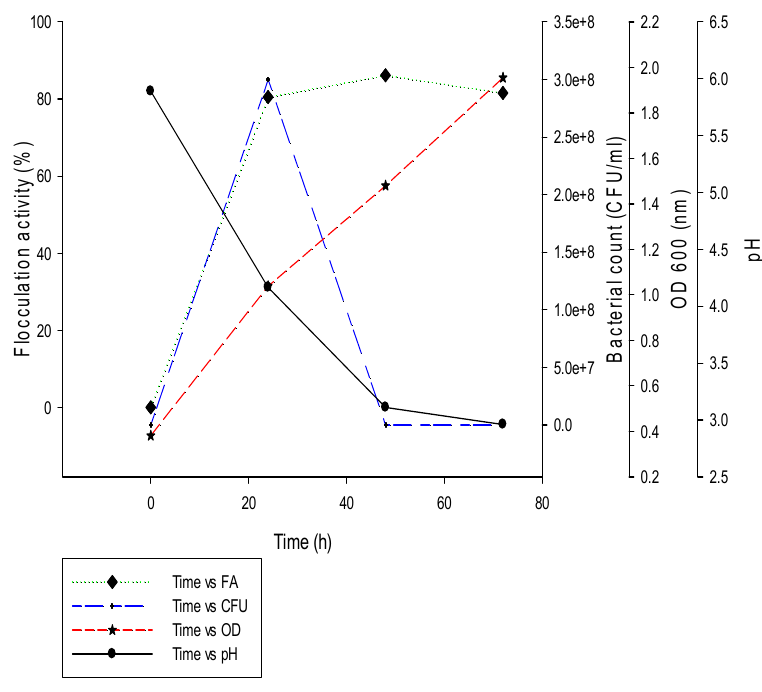
Figure 2. Time Course Profile of Bioflocculant Production by Bacillus sp.